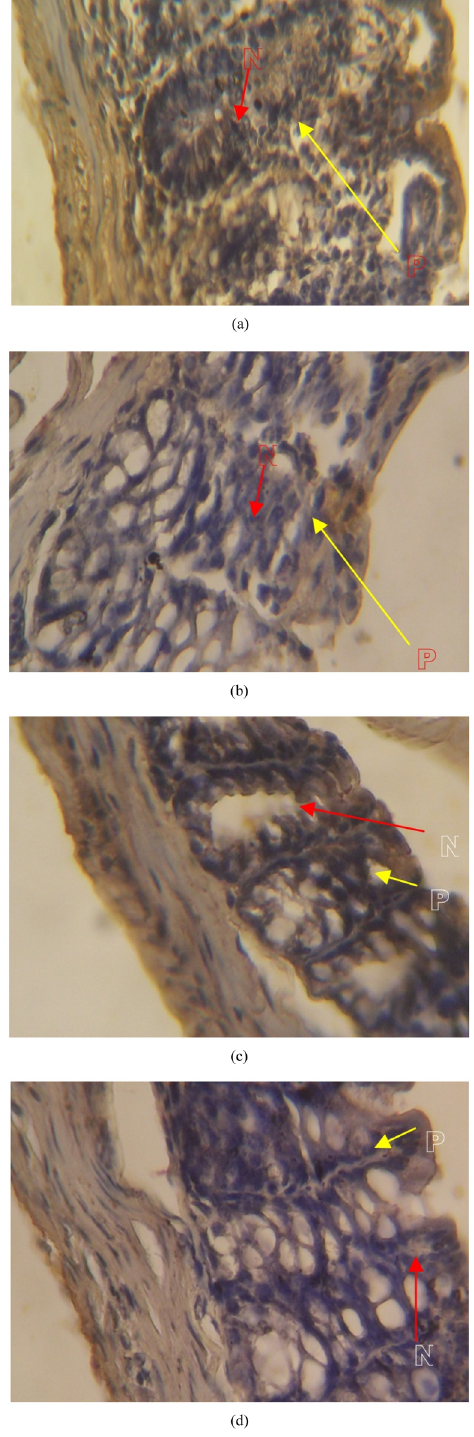
Figure 1: Expression of wild - type p53 protein in se ’ i: ( a ) home industry, ( b ) modern industry, ( c ) without nitrite and ( d )